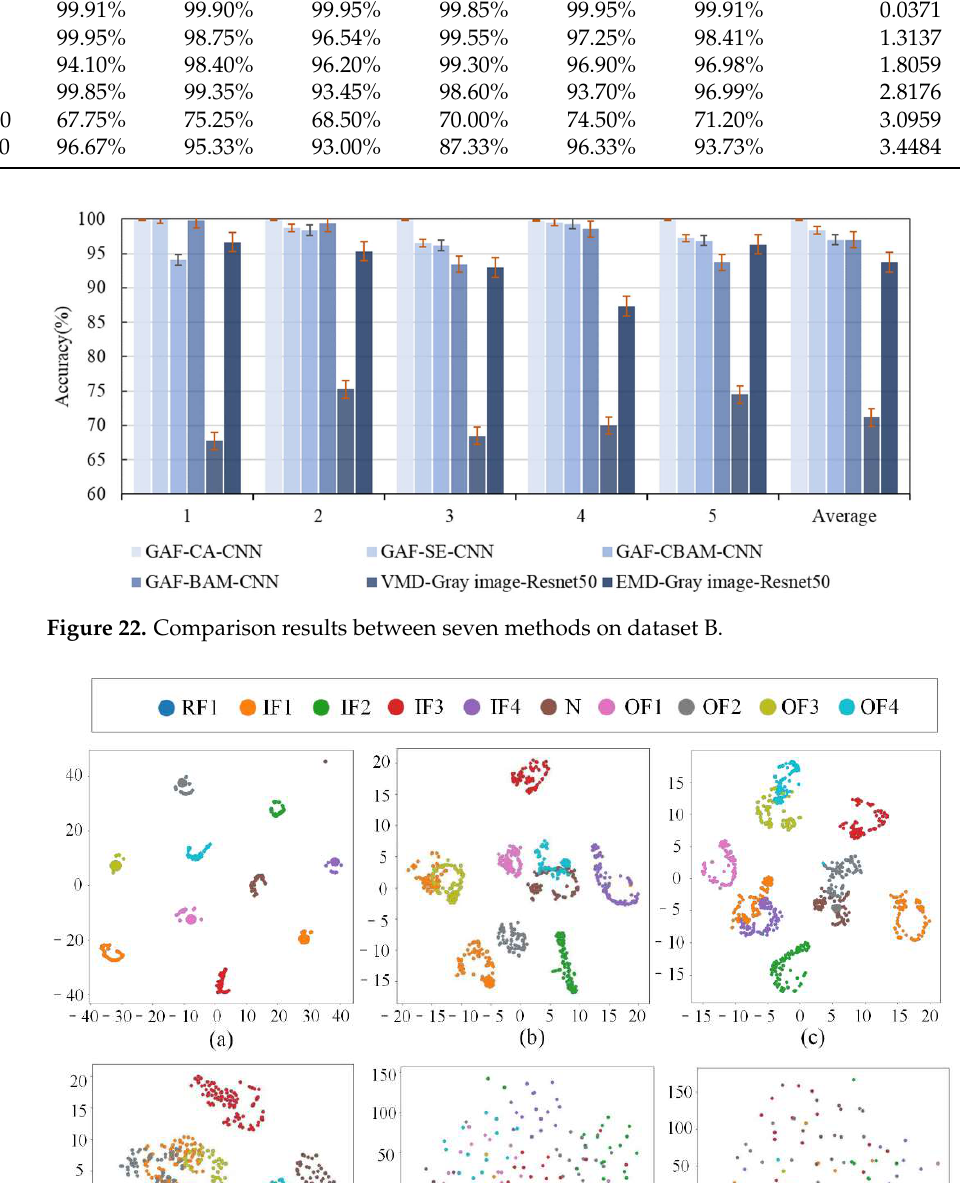
Figure 23. Visualization of different diagnostic results on dataset B, ( a ) The proposed method, ( b ) GAF-SE-CNN, ( c ) GAF-CBAM-CNN, ( d ) GAF-BAM-CNN, ( e ) VMD-Gray image-Resnet50, ( f ) EMD-Gray image-Resnet50.